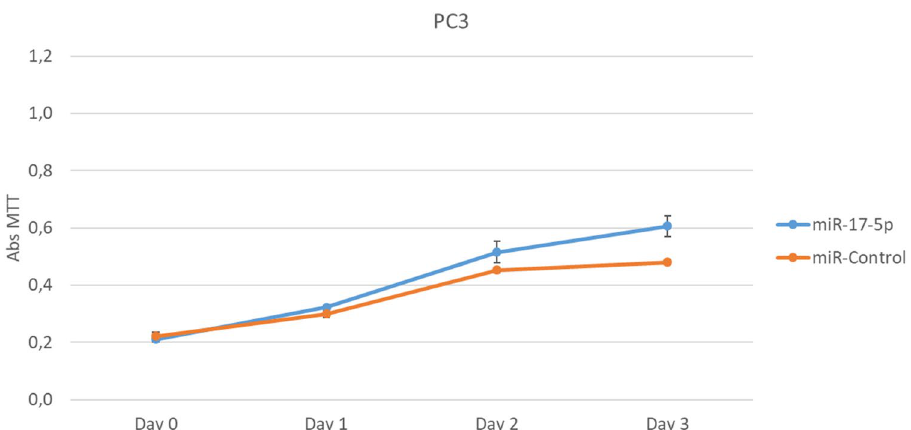
Figure 4. Cell proliferation was measured in PC3 and DU145 cells, and compared with control cells that were not transfected with miR-17-5p. PC3 Cell lines transfected with miR-17-5p showed increased proliferation compared with controls (representative of three experiments), while DU145 cell line did not have significant variation. Results from all experiments are shown in supplementary (Supplementary Figure